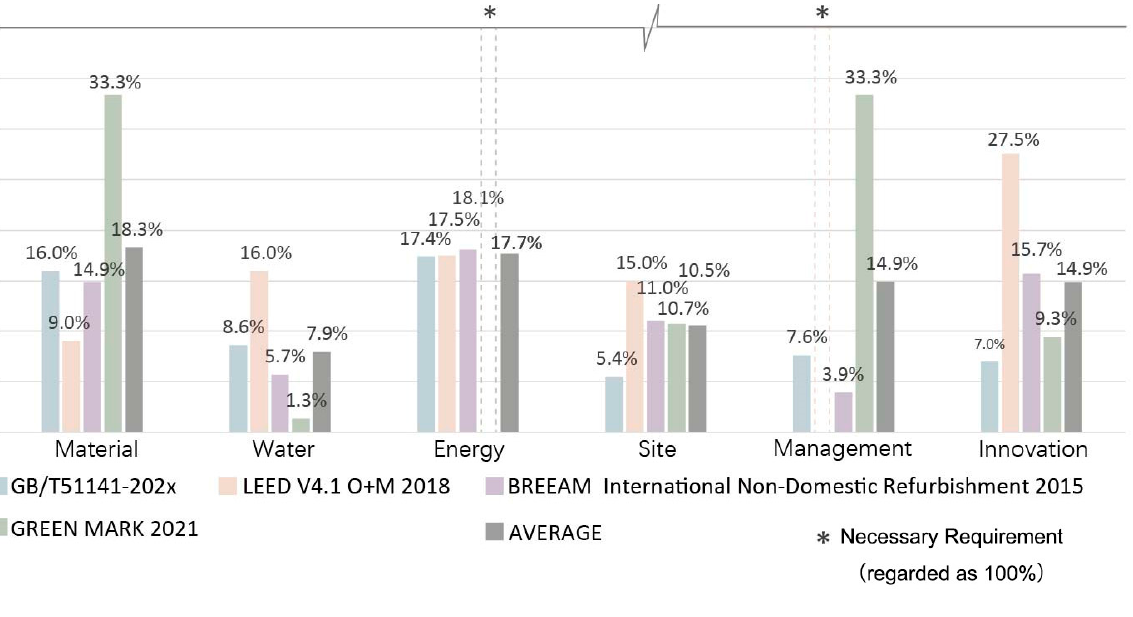
Figure 5. Analysis of scope weights.